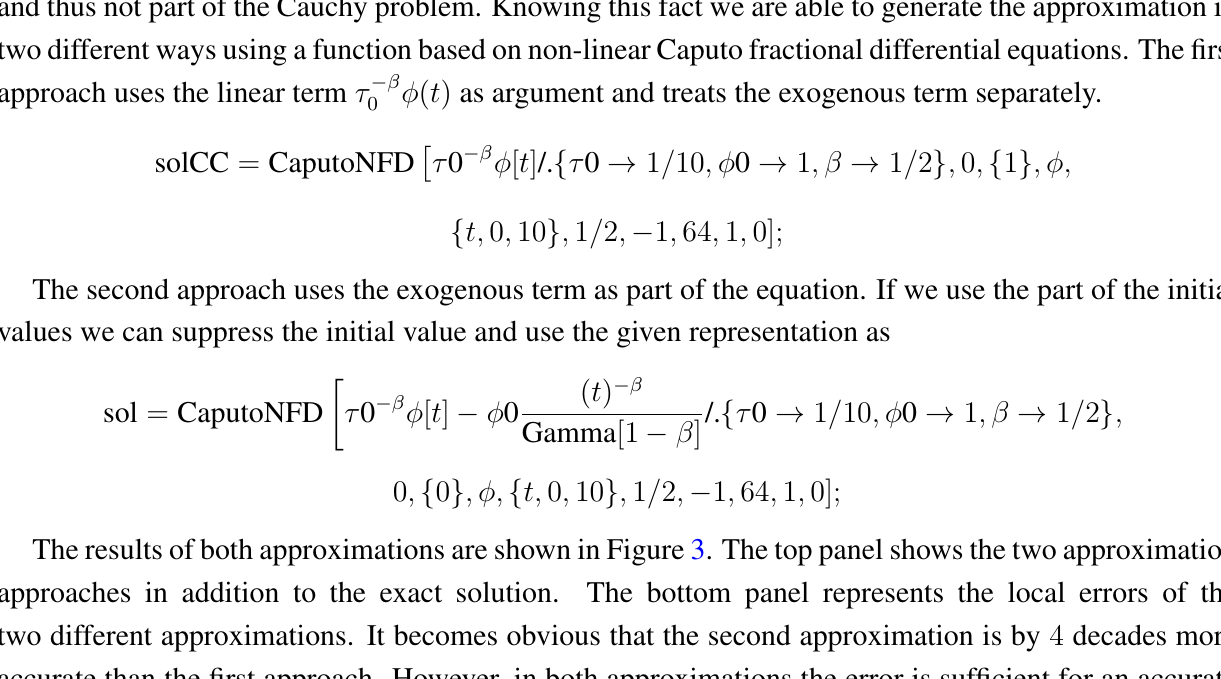
= 1 and was set to ϕ 0 0 ( (cid:0) 10 t ) . The Sinc approximation 1